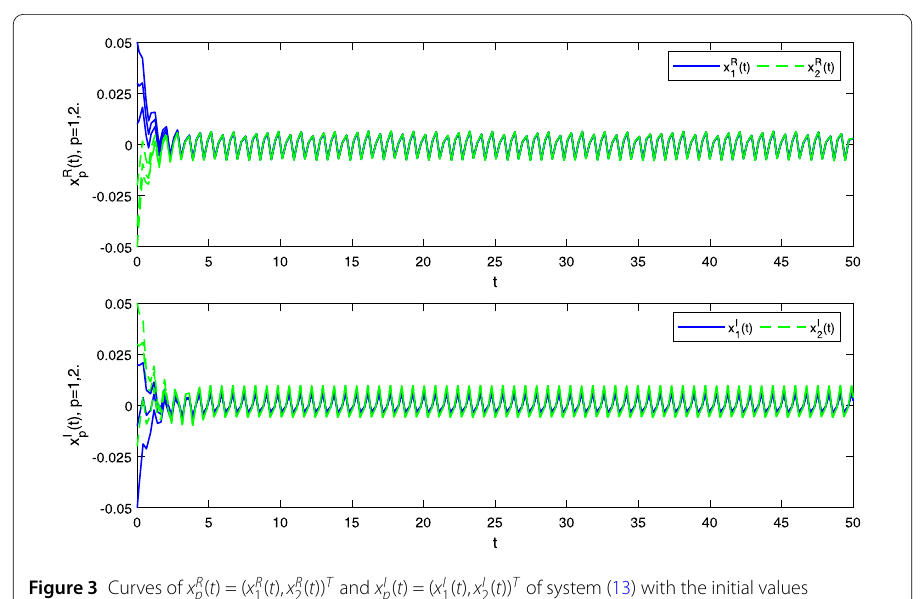
Figure 3 Curves of x R p ( t ) = ( x R 1 ( t ), x R 2 ( t )) T and x I p ( t ) = ( x I 1 ( t ), x I 2 ( t )) T of system (13) with the initial values ( x R 1 (0), x R 2 (0)) T = (0.01,–0.02) T ,(0.03,–0.04) T ,(0.05,–0.05) T